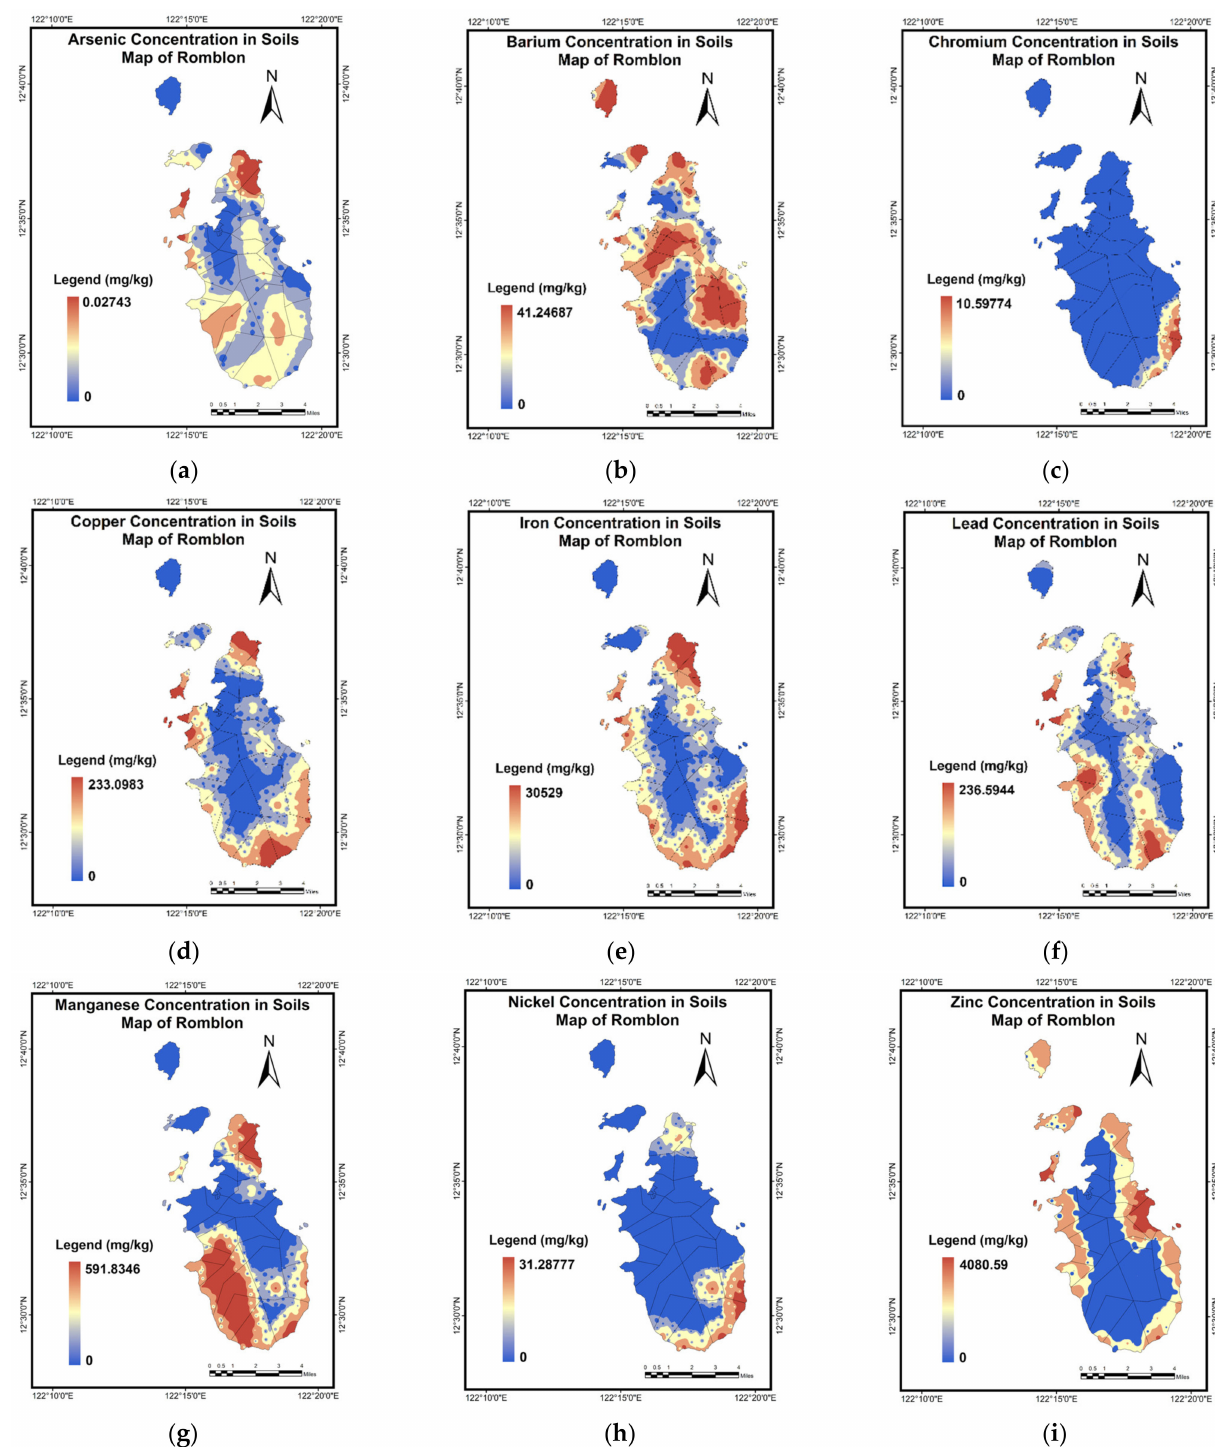
Figure A2. Heavy metal concentration of soils: ( a ) Arsenic, ( b ) Barium, ( c ) Chromium, ( d ) Copper, ( e ) Iron, ( f ) Lead, ( g ) Manganese, ( h ) Nickel, ( i )